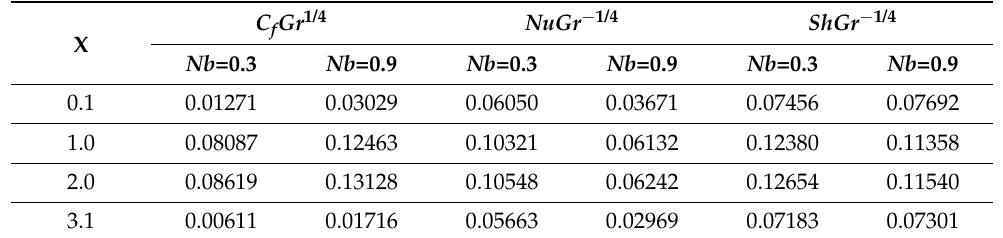
Table 5. Outcomes of the Brownian motion parameter N b on (a) the skin friction coefficient C f Gr 1/4 , (b) Nusselt NuGr − 1/4 , and (c) the Sherwood number ShGr − 1/4 when Nt = 0.2, Sc = 10.0, N = 1.1, and Pr =